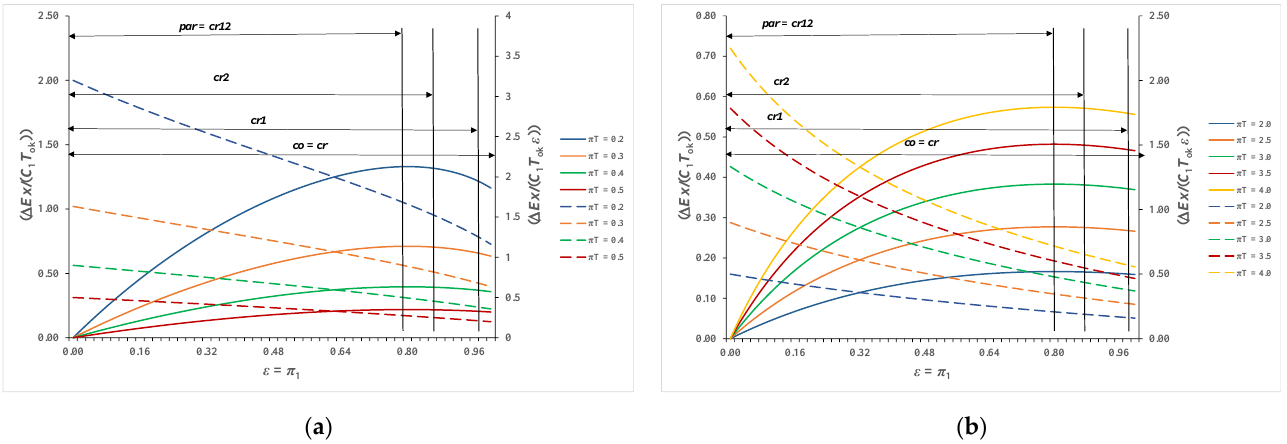
Figure 14. Dependence of exergy destruction and the ratio of exergy destruction to effectiveness of the recuperator on ε and π T for π 3 = 0.25: ( a ) 0.2 < π T < 0.5; ( b ) 2.0 < π T < 4.0. The diagram in Figure 14a shows exergy destruction (continuous lines) and ratio (dashed lines) as a function of ε and π T where 0.20 ≤ π T ≤ 0.60 with a step of 0.10. It is